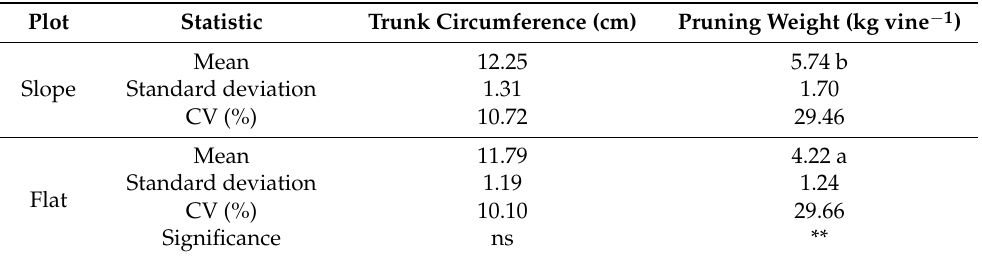
Table 4. Descriptive statistics and analysis of variance (ANOVA) for the vine vigor parameters of the slope and flat plots under